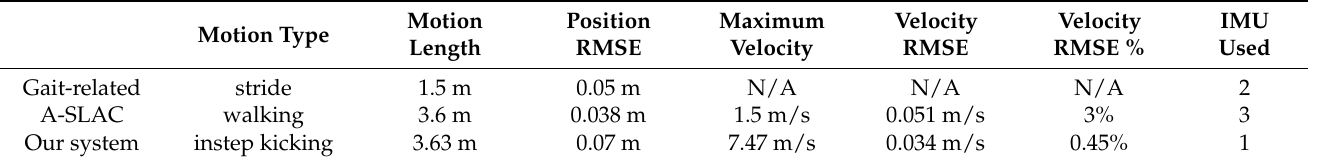
Table 2. Accuracy evaluation results obtained for different types of motion using different IMU-based systems. For the position RMSE in the gait-related system and A-SLAC system, the error is calculated according to the direction of movement, while our system performs it with the 3D